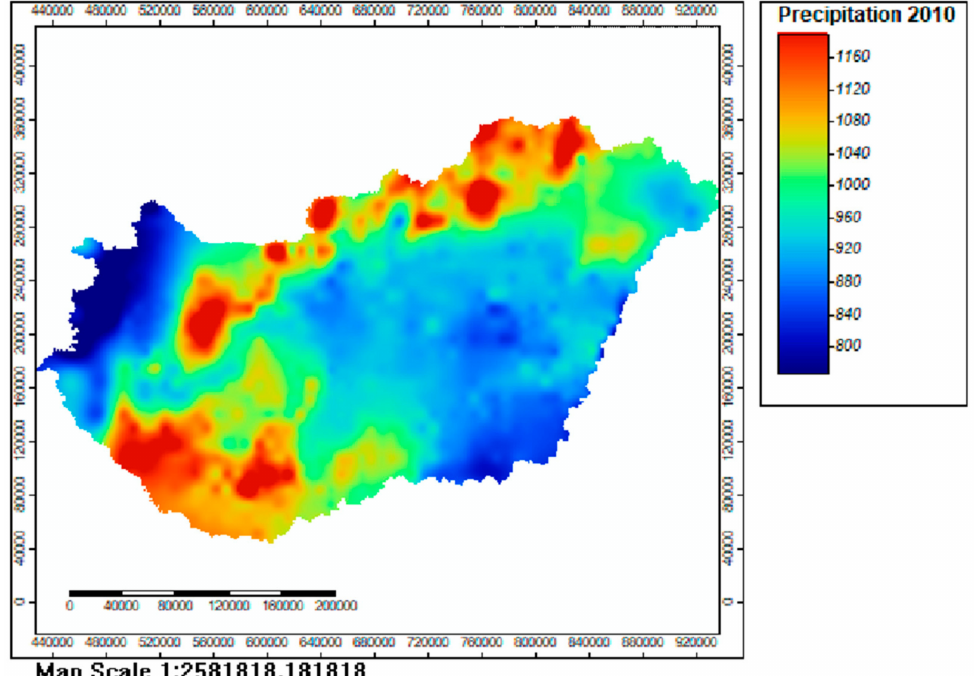
Figure 2. Annual precipitation in Hungary (mm) in 2010.